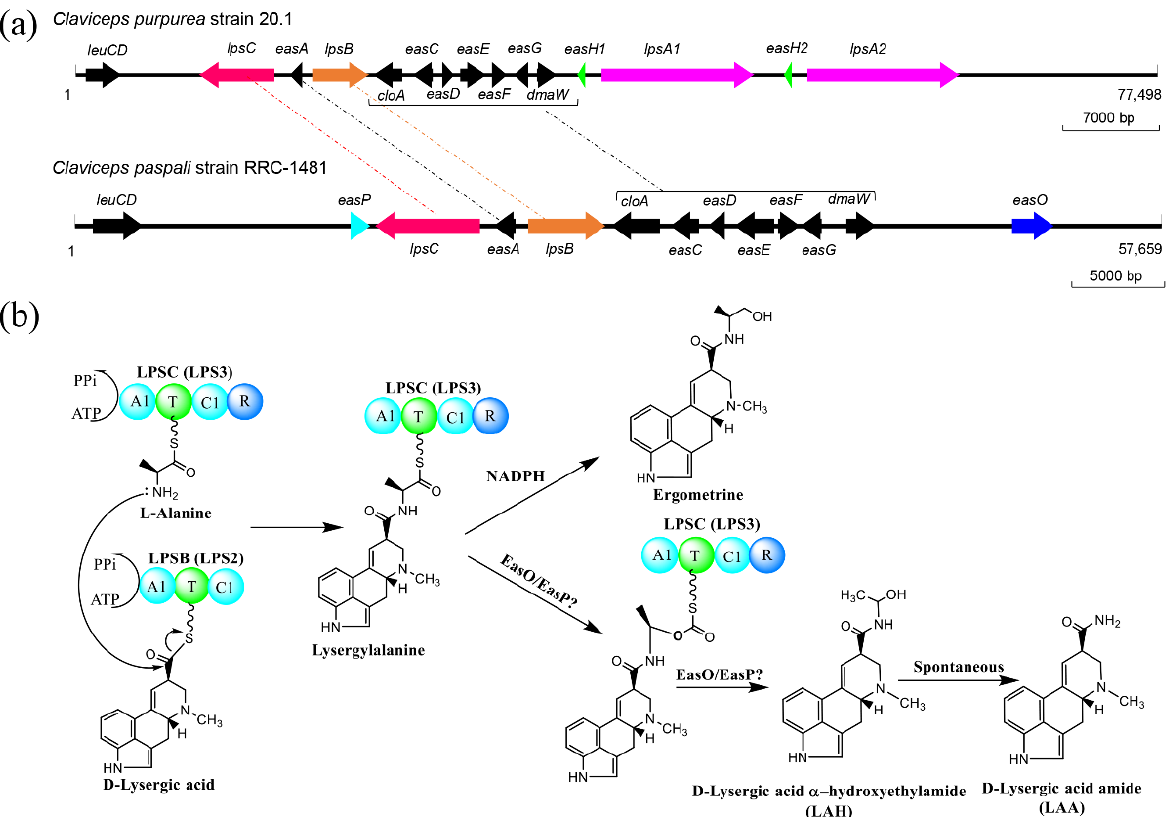
Figure 1. ( a ) Comparison of the two EAS gene clusters from C. purpurea and C. paspali . ( b ) The proposed biosynthetic pathway of lysergic acid amides in C. paspali .